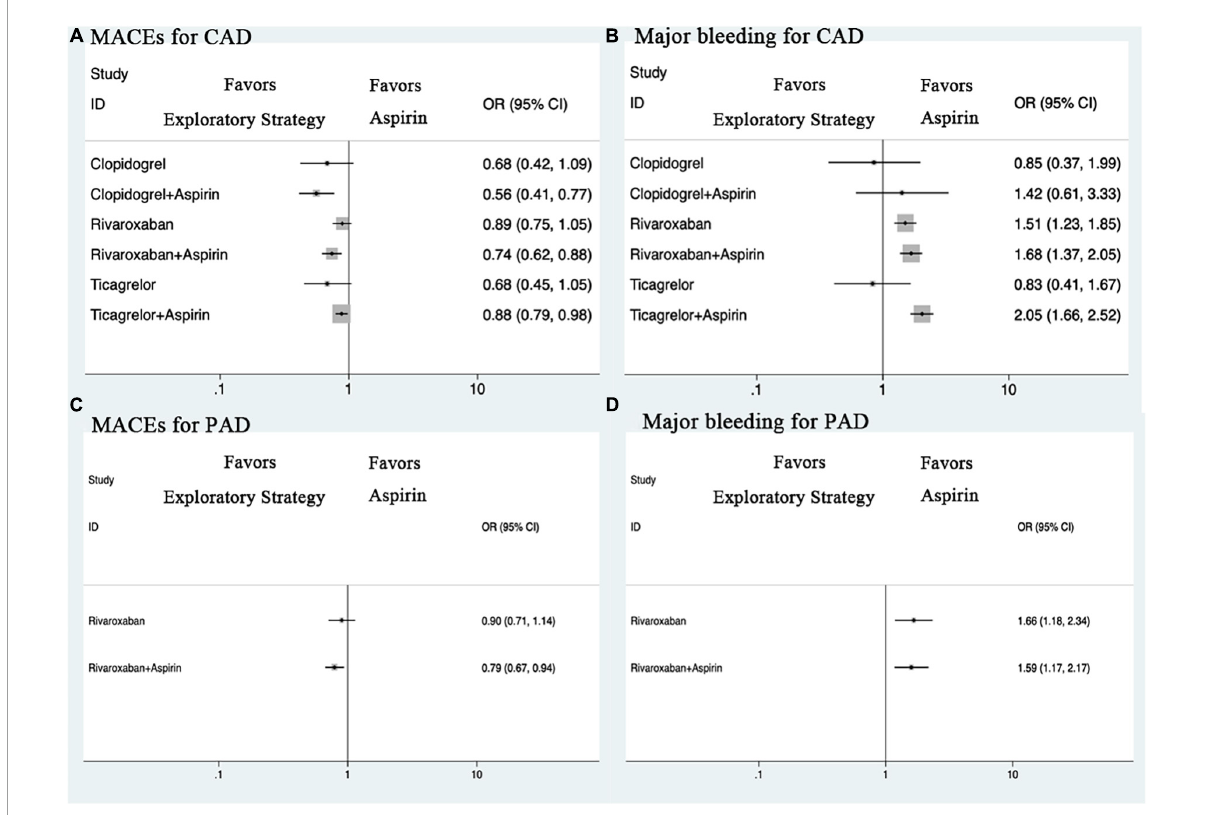
FIGURE5 Forest plots for outcomes in patients with CAD or PAD. (A) MACEs for CAD. (B) Major bleeding for CAD. (C) MACEs for PAD. (D) Major bleeding for PAD. CAD, coronary artery disease; CI, credible intervals; MACEs, major adverse cardiovascular and cerebrovascular events; OR, odds ratio; PAD, peripheral artery